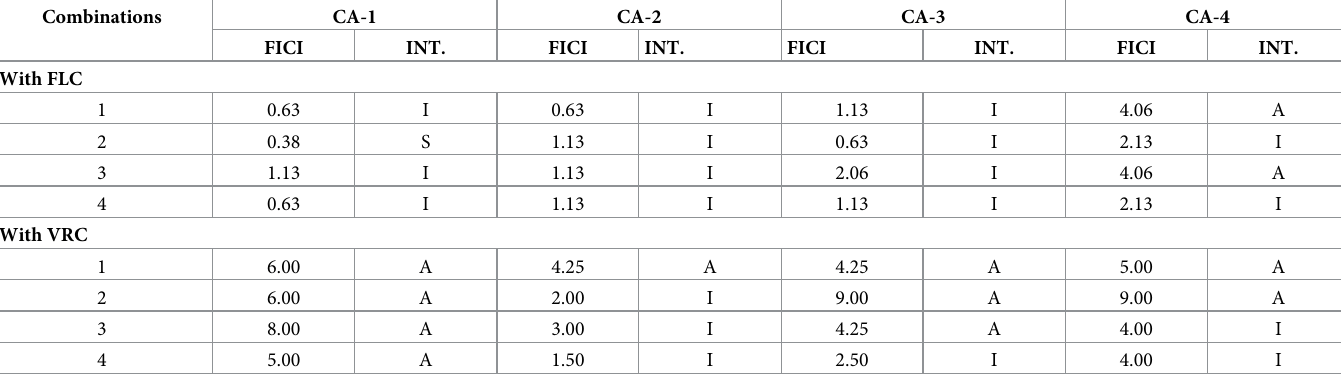
Table 5. Effect of the combined antifungal activity of isolated compounds and fluconazole or voriconazole by the checkerboard microbroth dilution assay.